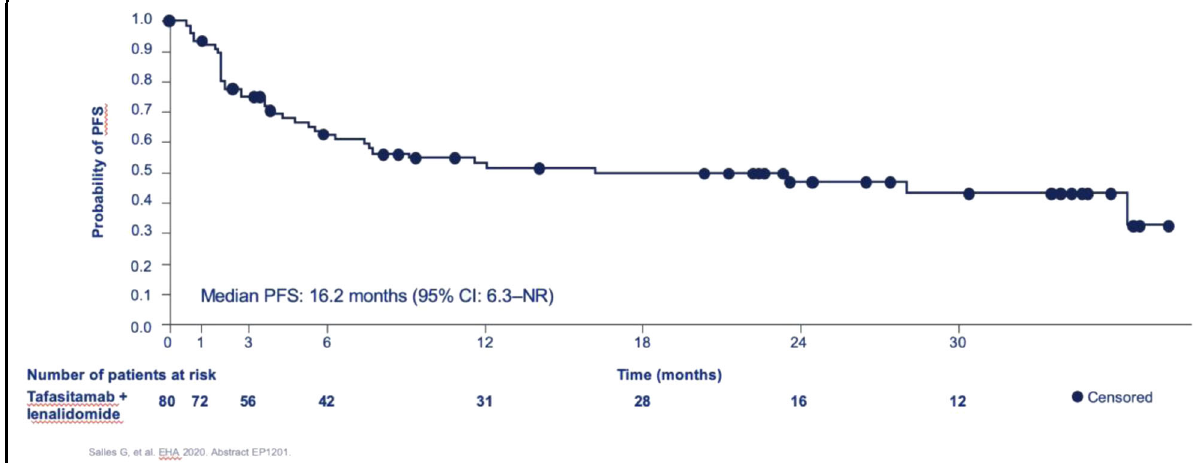
Fig. 3 Progression-free survival in the L-MIND Study (courtesy of Morphosys). The median PFS is 16.2 months (95% CI: 6.3-NR).